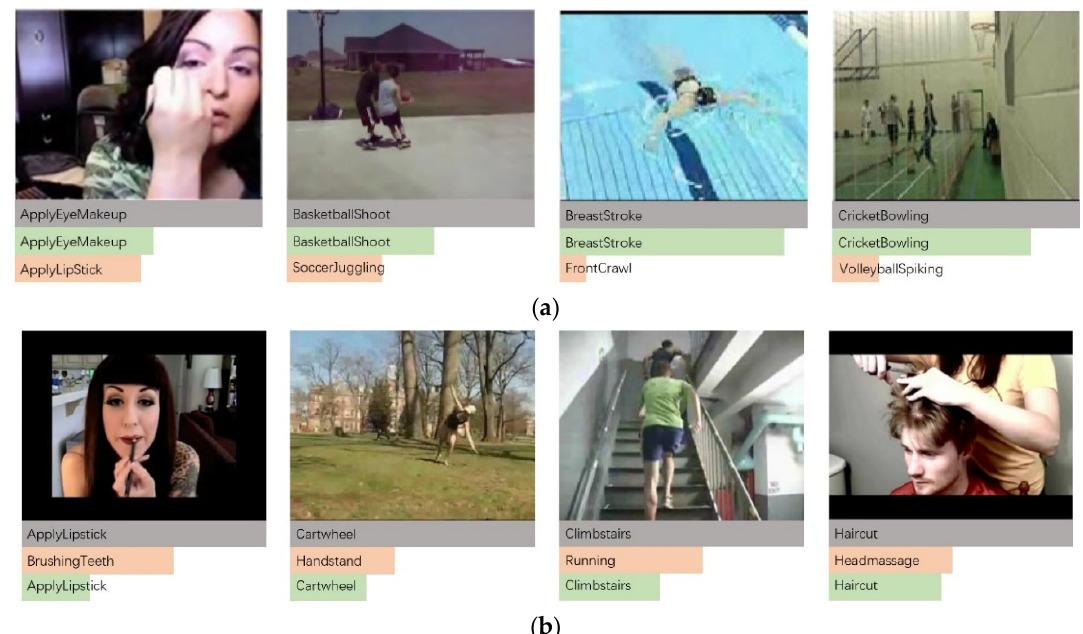
Figure 11. Some examples of the prediction results. For each video, we used the top two categories’ predicted scores. The gray bars indicate the ground truth label, the green and orange bars distinguish the correct and incorrect predictions, respectively. The length of each bar indicates the confidence. ( a ) The correct examples of the prediction results. ( b ) The incorrect examples of the prediction results.